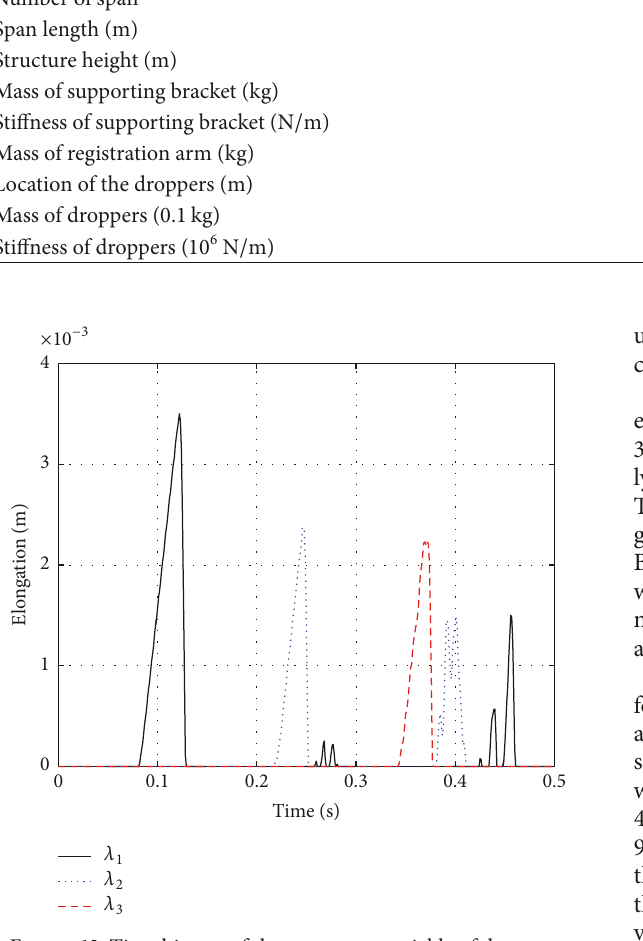
Figure 13: Time history of the parameter variable of